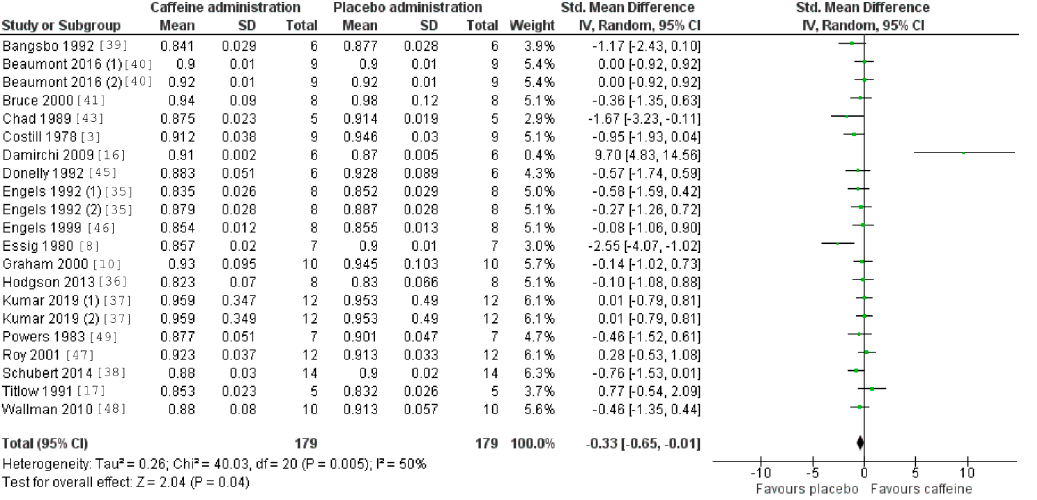
Figure 6. E ff ect of ca ff eine ingestion as compared to a placebo on respiratory exchange ratio (RER) during exercise. The forest plot shows standardized mean di ff erences with 95% confidence intervals (CI) for 19 studies that included a measurement of fat oxidation rate or measurements that allowed the calculation of fat oxidation rate (i.e., oxygen uptake and